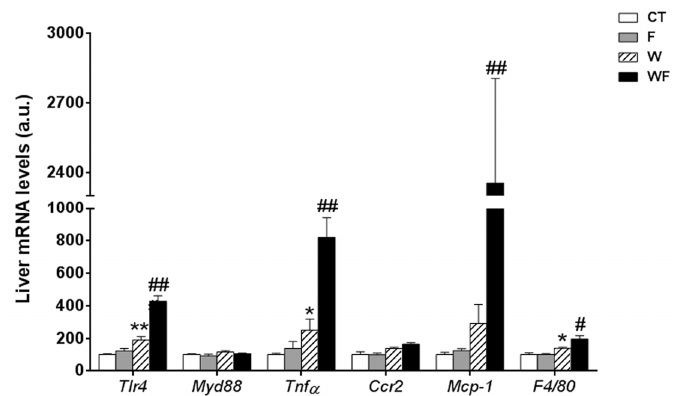
Figure 2. Bar plots showing the relative levels of specific mRNAs of pro-inflammatory molecules from Control (CT, mice fed standard solid-chow), Fructose (F, mice fed standard solid-chow plus a 15% fructose solution ad libitum), Western (W, mice fed Western solid-chow), and Western+Fructose (WF, mice fed Western solid-chow plus a 15% fructose solution ad libitum), represented as mean (a.u., arbitrary units) ± SEM of five different liver samples. * p < 0.05, ** p < 0.01 vs. CT values; # p < 0.05, ## p < 0.01 vs. W values.